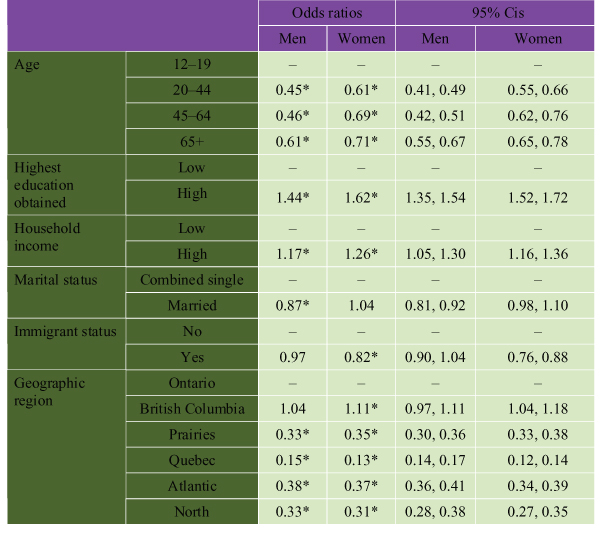
Odds of Reporting Multiple Health-Promoting Practices1,2 Controlling for Selected Demographic Factors. Source: Statistics Canada, CCHS, 2000–2001.1 Multiple health promoting practices is defined as having two or more of the following health promoting behaviours: being physically active, consulting an alternative health care provider, doing something in previous 12 months to improve health, consuming fruits and vegetables more than 5 times/serving per day.  2 All results were from Statistics Canada bootstrap programs.  * Outcome is with multiple promoting practices.